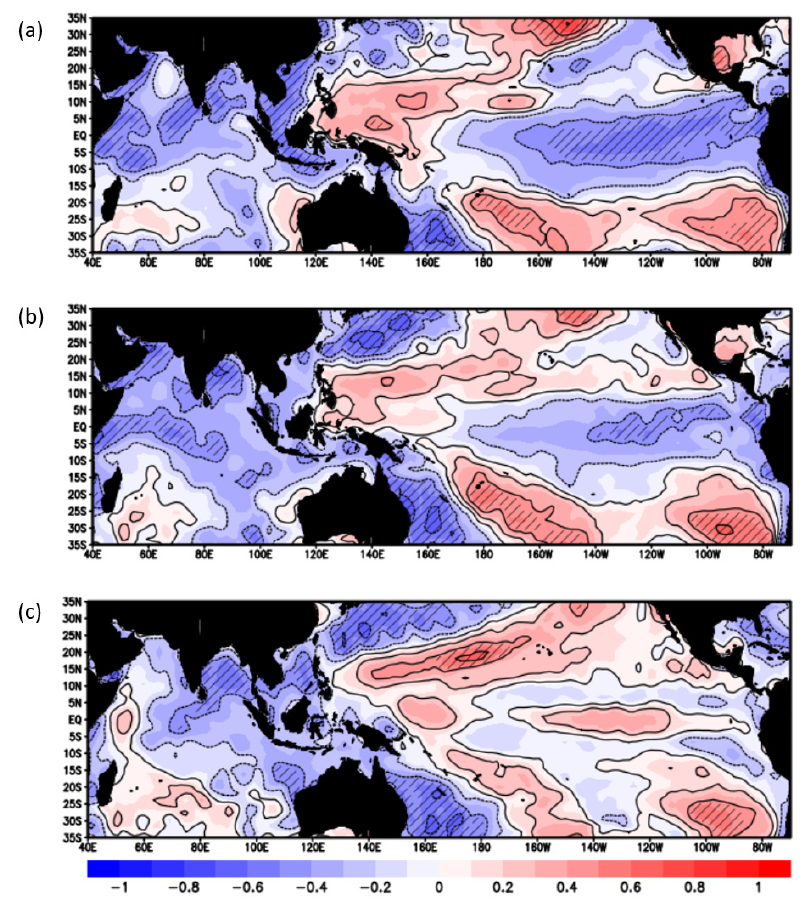
Figure 11. Correlation coefficient between BSL days and the SST anomalies (°C) during ( a ) January– March, ( b ) March–May, and ( c ) May–July. Areas significant at 0.05 level are hatched.